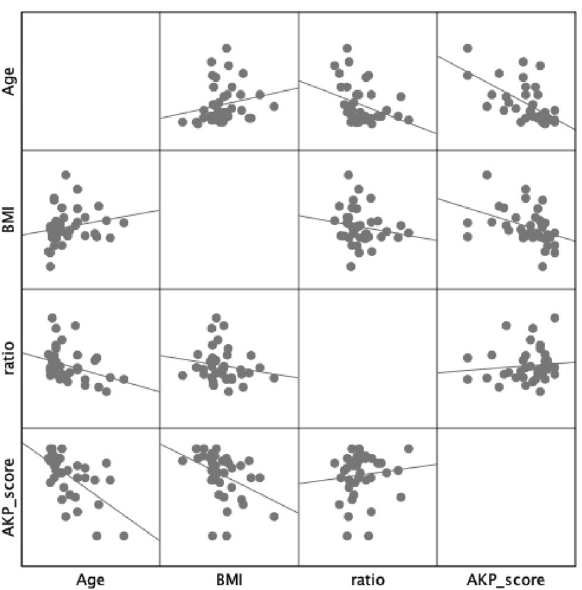
Figure 3. Scatterplots showing the correlation of each variable with regression lines.